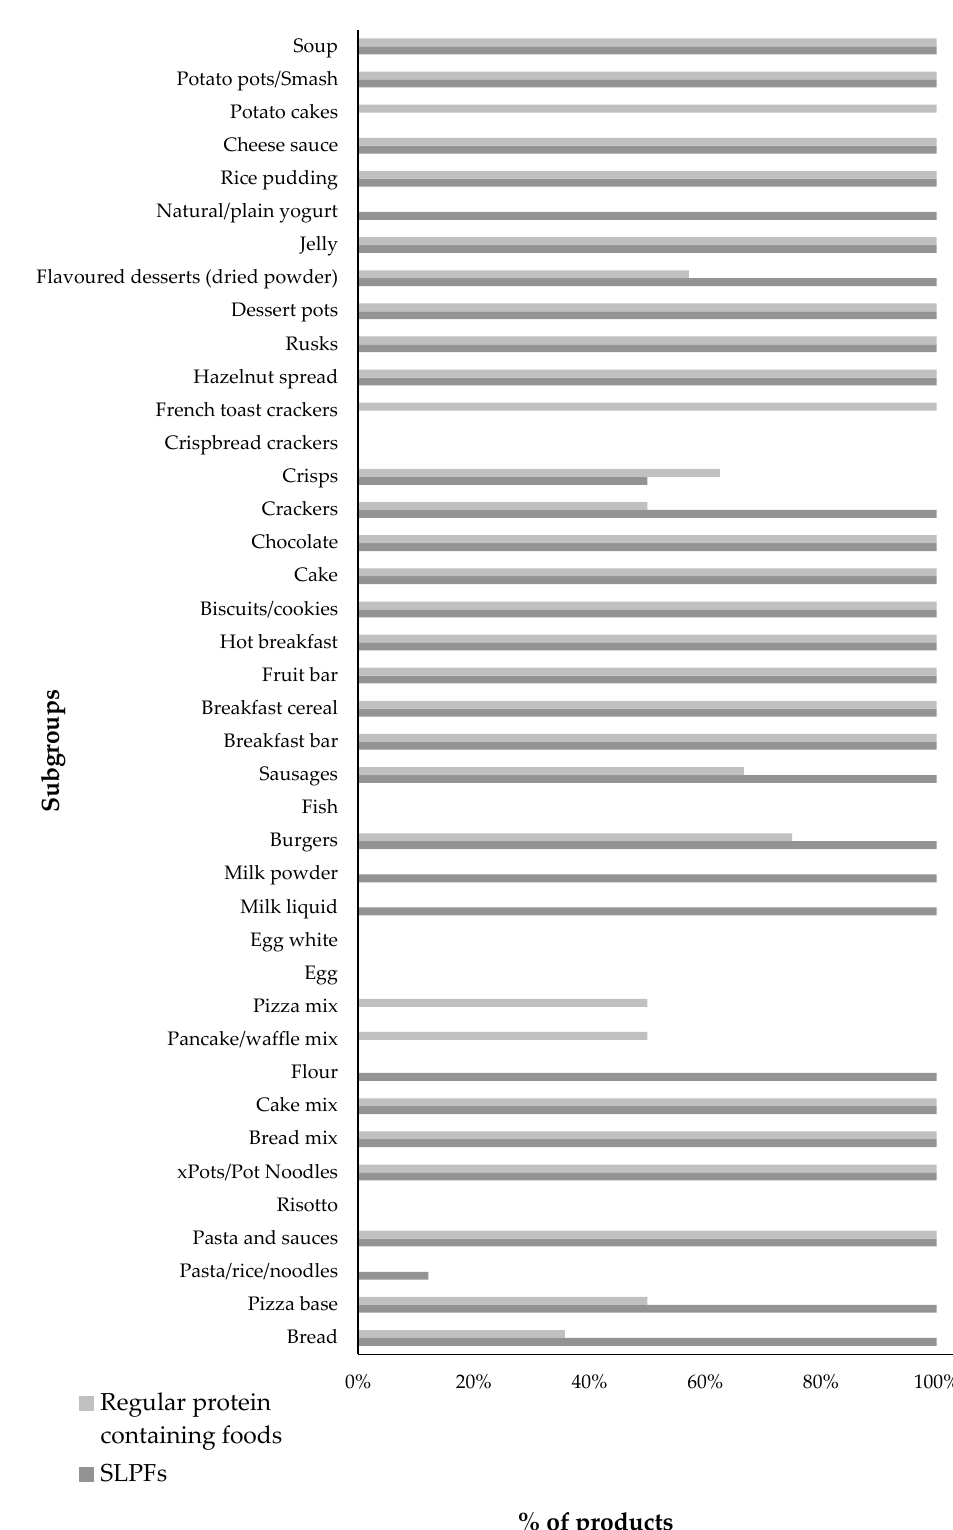
Figure 1. Percentage of regular and special low protein food (SLPF) products containing added sugar in their ingredient list by subgroup.